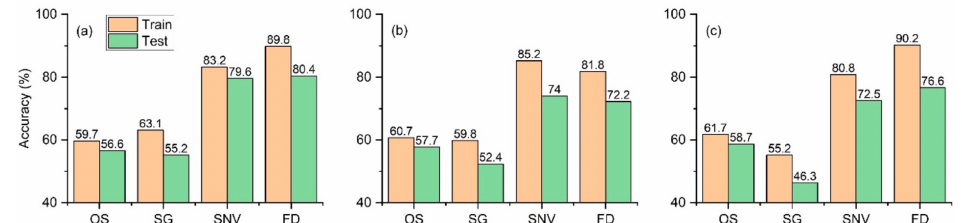
Figure 4. Identification accuracy based on the hyperspectral reflectance of three classifiers with di ff erent pretreatments. ( a ) Grid search optimization support vector machine (GS-SVM) classifier; ( b ) ensemble learning (EL) classifier; and ( c ) artificial neural network (ANN)